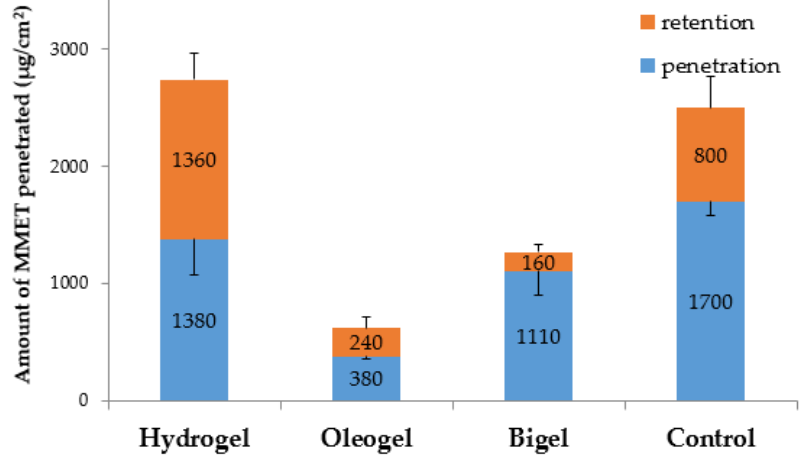
Figure 8. Ex vivo cumulative penetration and tissue retention of MMET from hydrogel, oleogel and bigel formulations as compared to commercially available ointment with MET in porcine buccal mucosa (expressed as the amount of drug penetrated per unit of tissue area).